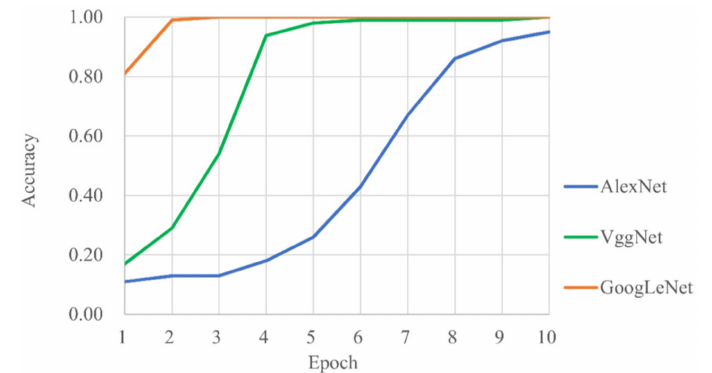
Figure 15. Accuracy–epoch curve of three CNN